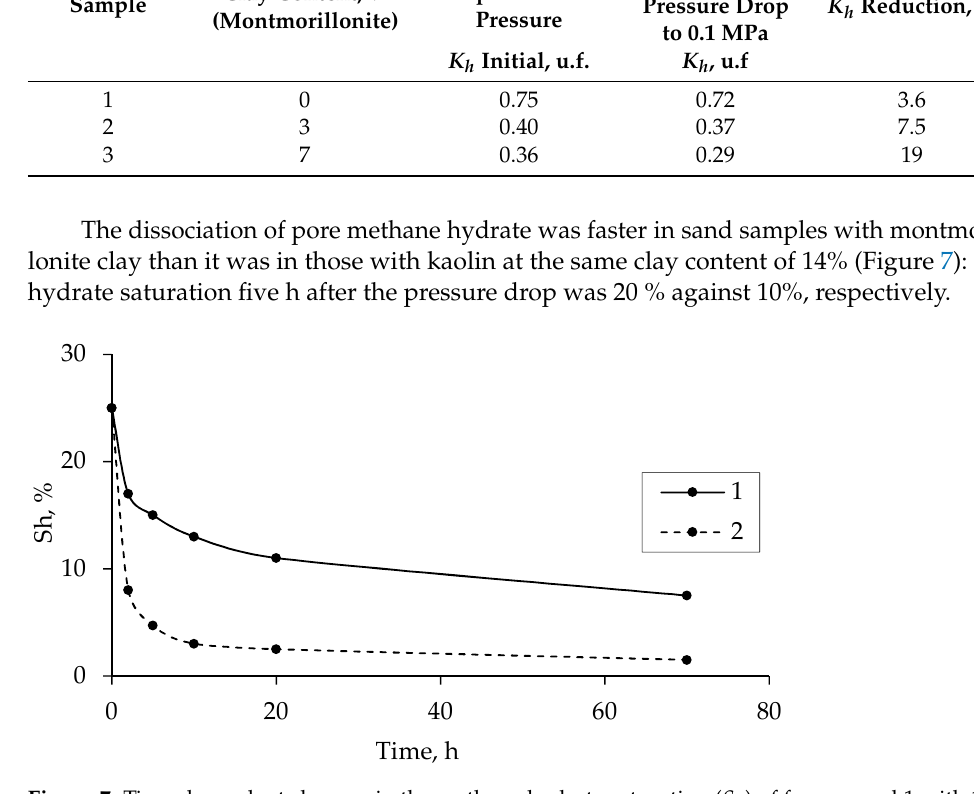
Figure 7. Time-dependent changes in the methane hydrate saturation ( S h ) of frozen sand 1 with 14% of kaolinite (1) and montmorillonite (2) clay (W = 14%) after the pressure dropped to 0.1 MPa at −6.5 °С. Black dots are experimental data; the solid line is a trend line of exponential approximation.